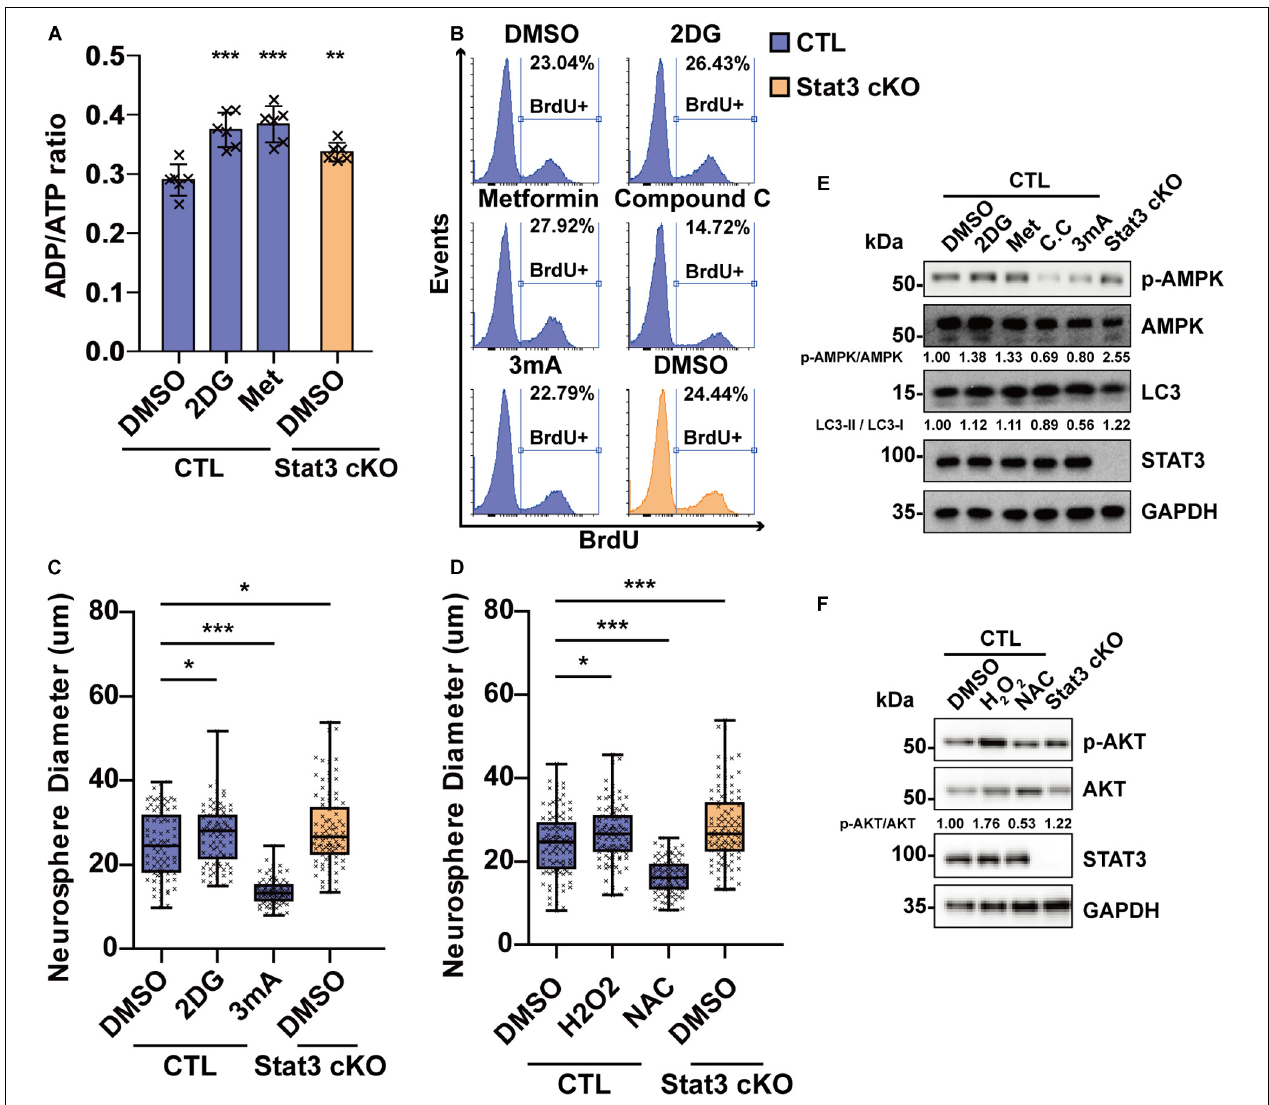
FIGURE 6 | Modulation of energy production and ROS level regulates neural progenitor proliferation. (A) ADP/ATP ratio change in CTL and Stat3 cKO neural progenitors under 2DG and Metformin treatment. Met, Metformin. Error bars represent mean ± standard deviations. (B) BrdU incorporation assay on CTL and Stat3 cKO neural progenitors in various treatments. (C) Neurosphere assay showed that 2DG treatment promoted the proliferation of neural progenitors, while 3 mA treatment inhibited cell proliferation. (D) Neurosphere assay on CTL and Stat3 cKO neural progenitors treated with H 2 O 2 or NAC. Error bars represent mean ± standard deviations. Box plot represents the median, maximum and minimum value as well as the interquartile range. * p < 0.05, ** p < 0.01, *** p < 0.005, n.s., not significant. (E) Western blot of neural progenitors treated by 2DG, Metformin (Met), Compound C (C.C) and 3 mA. (F) Western blot of neural progenitors treated by H 2 O 2 and